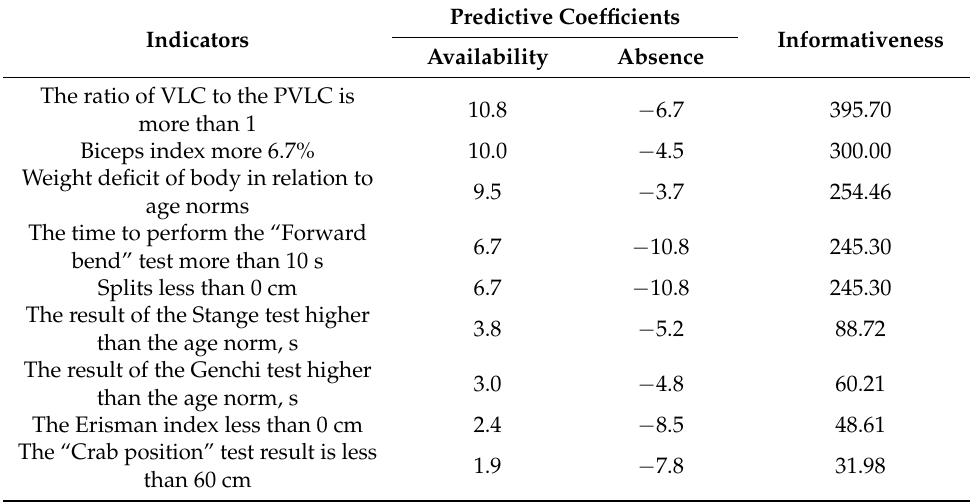
Table 1. Methods for predicting the athletes’ success in artistic